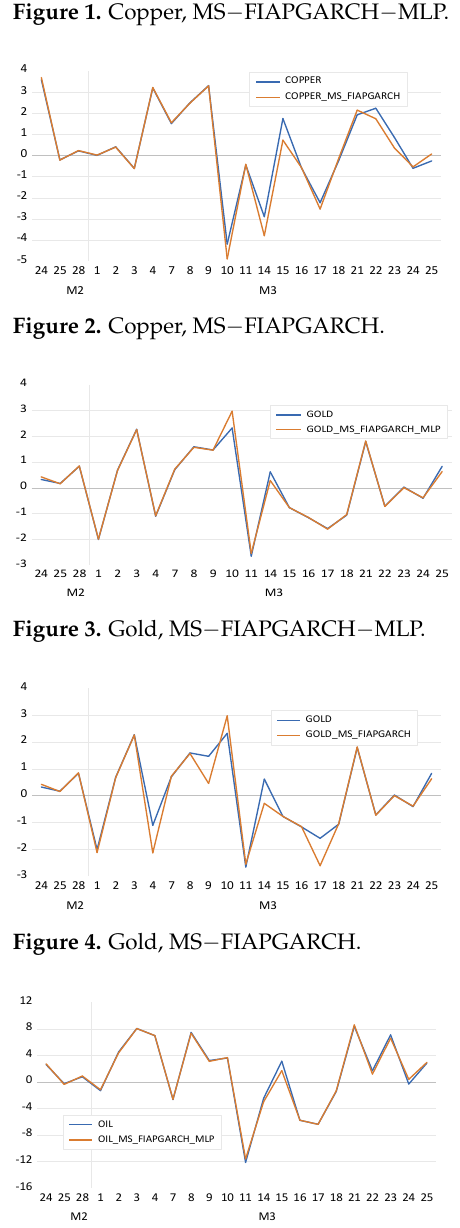
Figure 5. Oil, MS−FIAPGARCH−MLP.